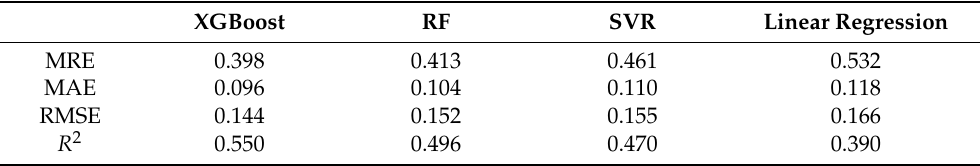
Table 4. Four environmental factors used for modeling analysis.